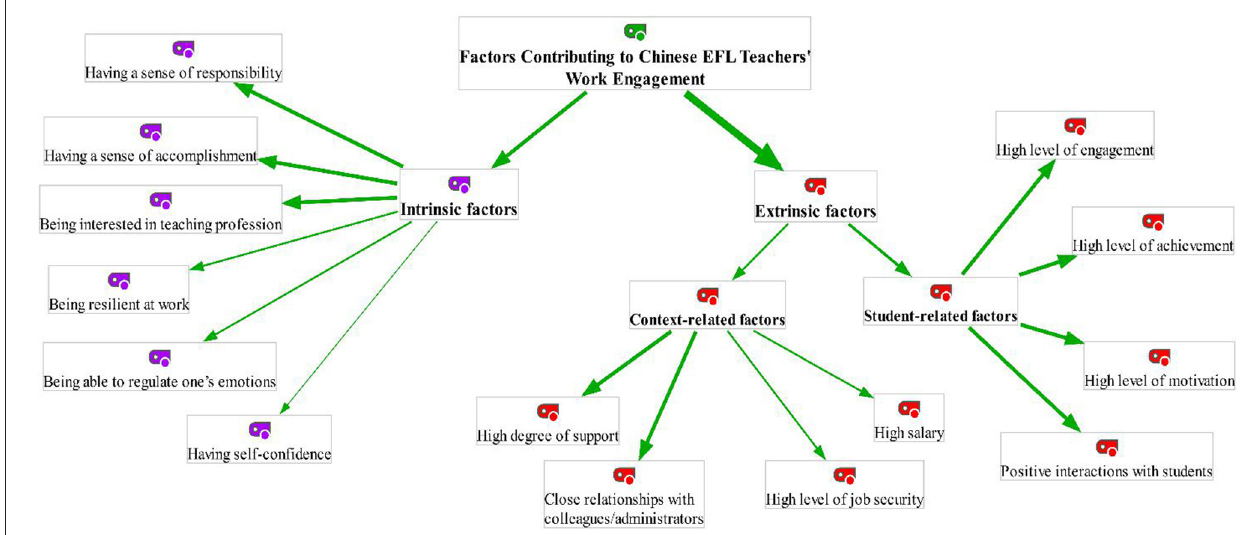
FIGURE 3 | Factors contributing to Chinese EFL teachers’ work